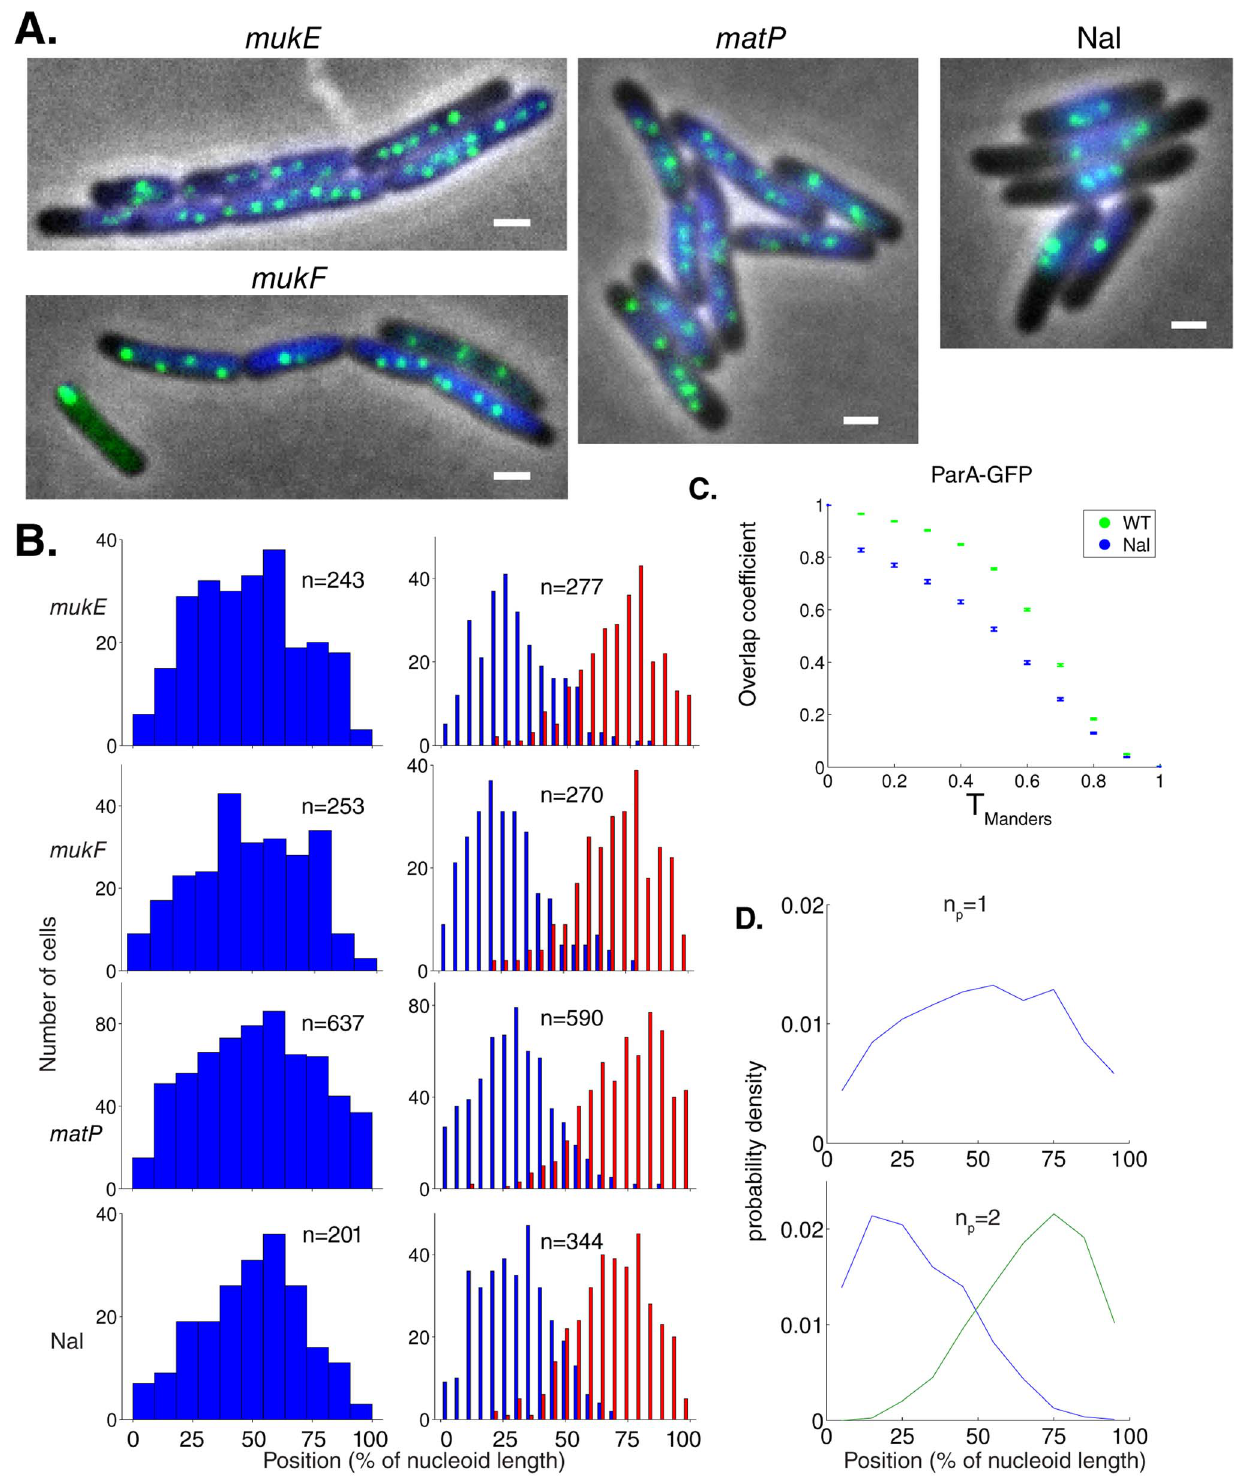
Fig. 7. Nucleoid morphology disruption causes aberrant plasmid focus positioning. ( A ) Fluorescence localization of ParB-GFP (green) and Hoechst DNA stain (blue) in mukE , mukF , matP mutants and wild-type cells treated with 50 m g/ml nalidixic acid (Nal). Scale bar: 1 m m; plasmid: pFS21 (mini-R1, parC1 + , parA + , parB::sfGFP , parC2 + ). ( B ) Histograms of plasmid foci positions (n p =1,2) for mutants/treatments described in ( A ) relative to nucleoid size. According to Kolmogorov-Smirnov tests, all distributions are broader than WT (Fig. 1C) with p , 10 2 2 except Nal n p =1: p , 0.05. ( C ) Manders overlap coefficients (error bars: standard error of the mean) of ParA-GFP comparing WT (n=678) and Nal-treated cells (n=862). Consistent with a decrease in the Pearson’s correlation coefficient r P (p , 10 2 38 ), ParA-GFP overlaps less with Hoechst in Nal-treated cells as compared to WT (p- values ranging from 10 2 51 to 10 2 144 ). ( D ) Time-averaged plasmid position distributions for directed motion model with short polymers obtained as in Fig. 2C from 124 independent simulations. Here, mobile DNA-bound ParA-ATP was now able to diffuse past a plasmid.